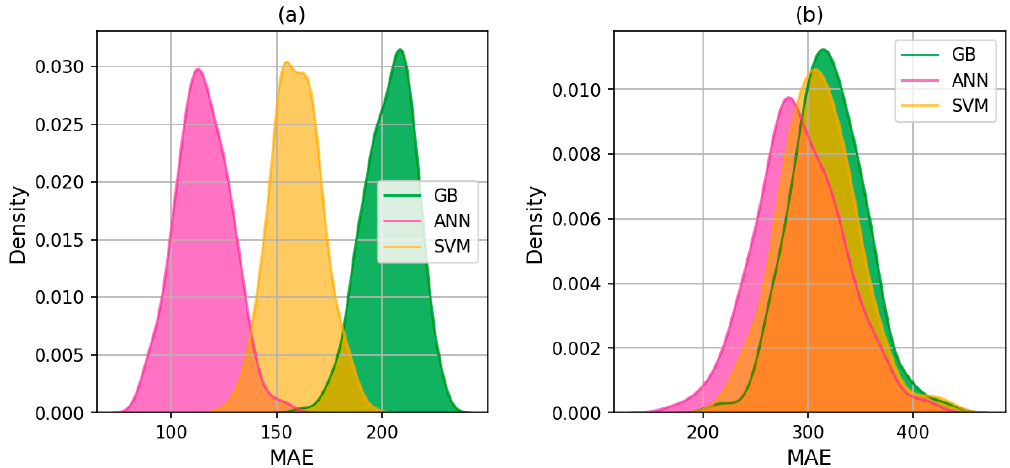
Figure 10. Density curve of the performance indicator MAE on 300 samplings with the: ( a ) Training set and ( b ) Testing set. Table 4. Summary of the 300 samplings using R criteria.